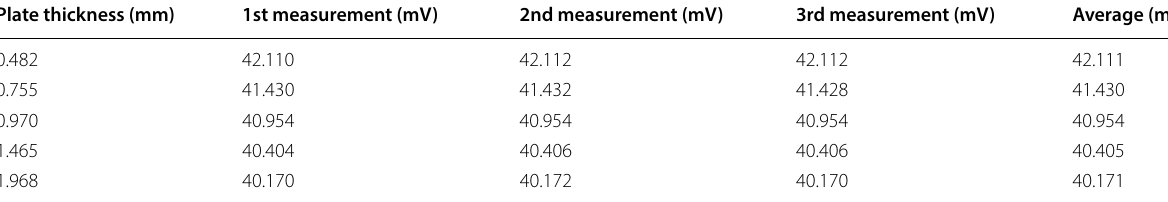
Table 2 The output voltages for various plate thicknesses Plate thickness (mm) 1st measurement